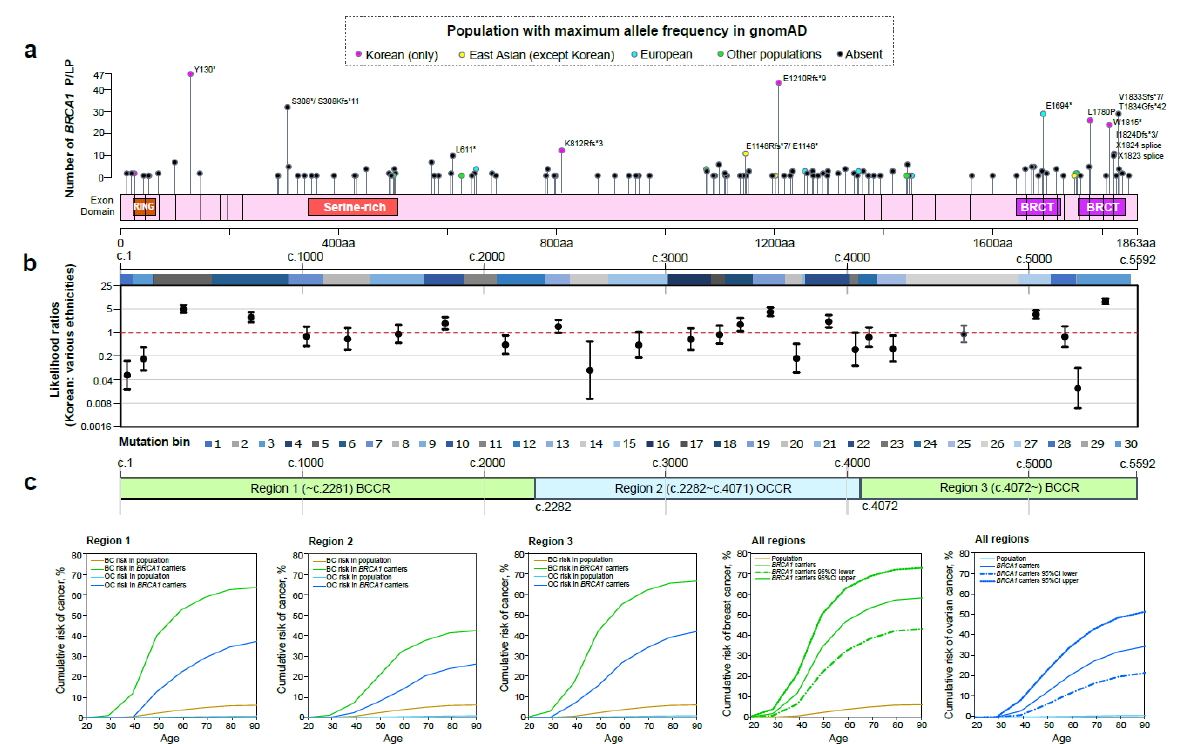
Figure 3. Analysis of pathogenic or likely pathogenic variants in BRCA1 . ( a ) Distribution of pathogenic or likely pathogenic variants (PLPVs) in BRCA1 in the Korean BRCA cohort. The population in gnomAD with maximum allele frequency at individual PLPVs is marked in each color in the circle of lollipop. ( b ) Comparative analysis of the proportion of BRCA1 PLPVs found in every mutation bin between the Korean BRCA and a large-scale cohort including various ethnicities over 6 continents. The 30 mutation bins across the span of the coding DNA sequence of BRCA1 were constructed using an algorithm in which each mutation bin contained approximately equal numbers of BRCA1 PLPVs in a previous study [21]. ( c ) Estimation of cumulative risks of breast and ovarian cancers for BRCA1 carriers by mutation region: region 1 (5′to c.2281, breast cancer cluster regions (BCCR)), region 2 (c.2282 to c.4071, ovarian cancer cluster regions (OCCR)), and region 3 (c.4072 to 3′, BCCR) [21,22]. RING, RING finger domain (24–64) by Pfam (http://pfam.xfam.org/ (accessed on 1 March 2021)); Serine-rich, serine-rich domain associated with BRCT (344–508); BRCT, BRCA1 C Terminus domain (1662–1723, 1756–1842); P/LP, pathogenic or likely pathogenic variants; BC, breast cancer; OC, ovarian cancer.